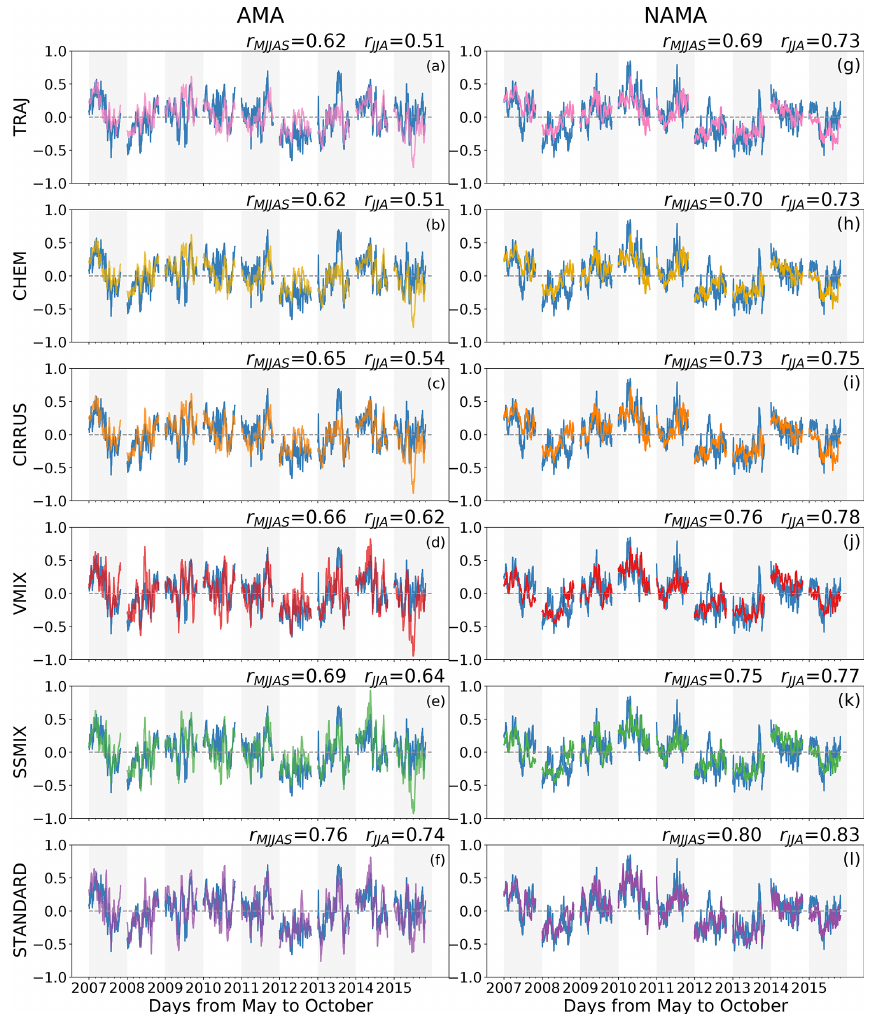
Figure 5. Boreal summer deseasonalized anomalies of water vapour in (a–f) the Asian Monsoon Anticyclone, AMA, and (g–l) the North American Monsoon Anticyclone, NAMA, for (top–bottom) TRAJ, CHEM, CIRRUS, VMIX, SSMIX, and STANDARD in comparison with MLS (blue line). Correlation values between each experiment and MLS are calculated from May to September ( r MJJAS ) and from June to August ( r JJA